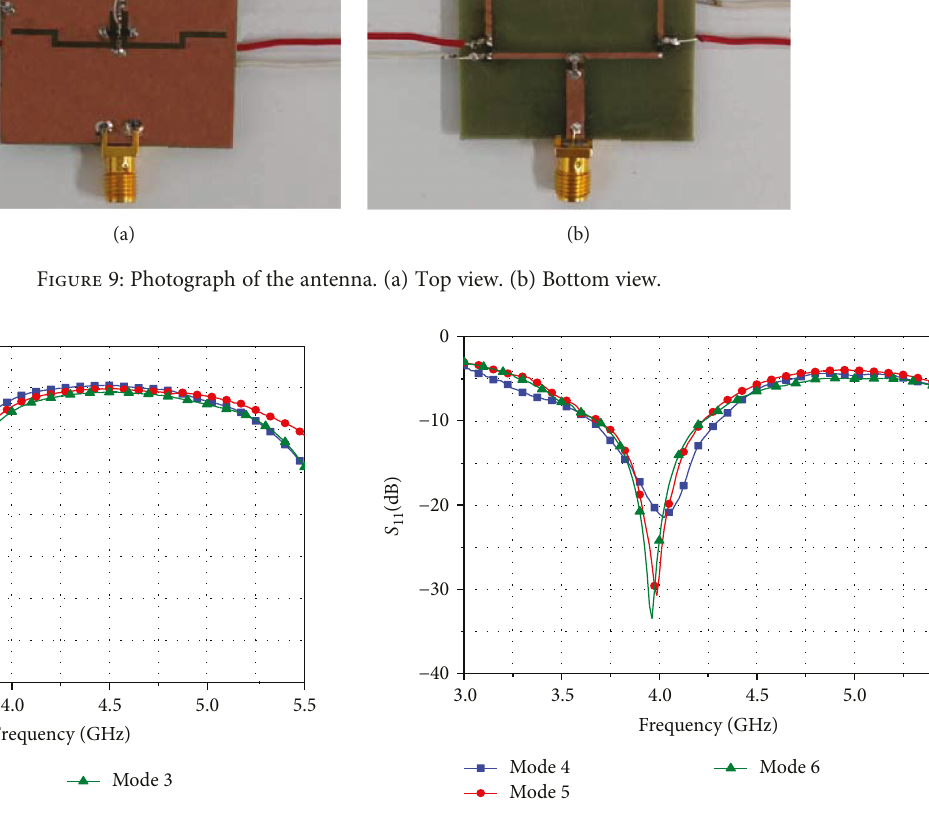
Figure 11: Measured input re fl ection coe ffi cients in modes 4, 5, and